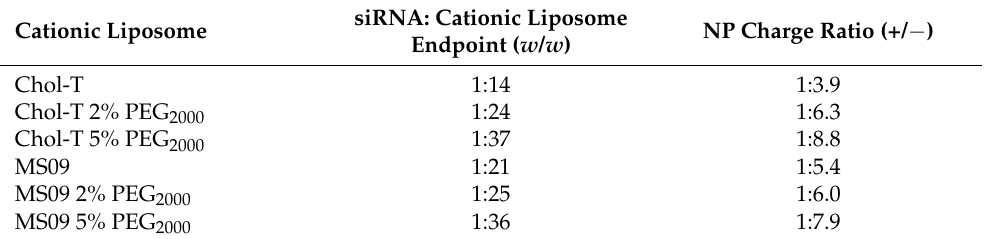
Table 5. Band-shift assay endpoints and charge ratios of the various cationic/PEGylated cationic liposomes.